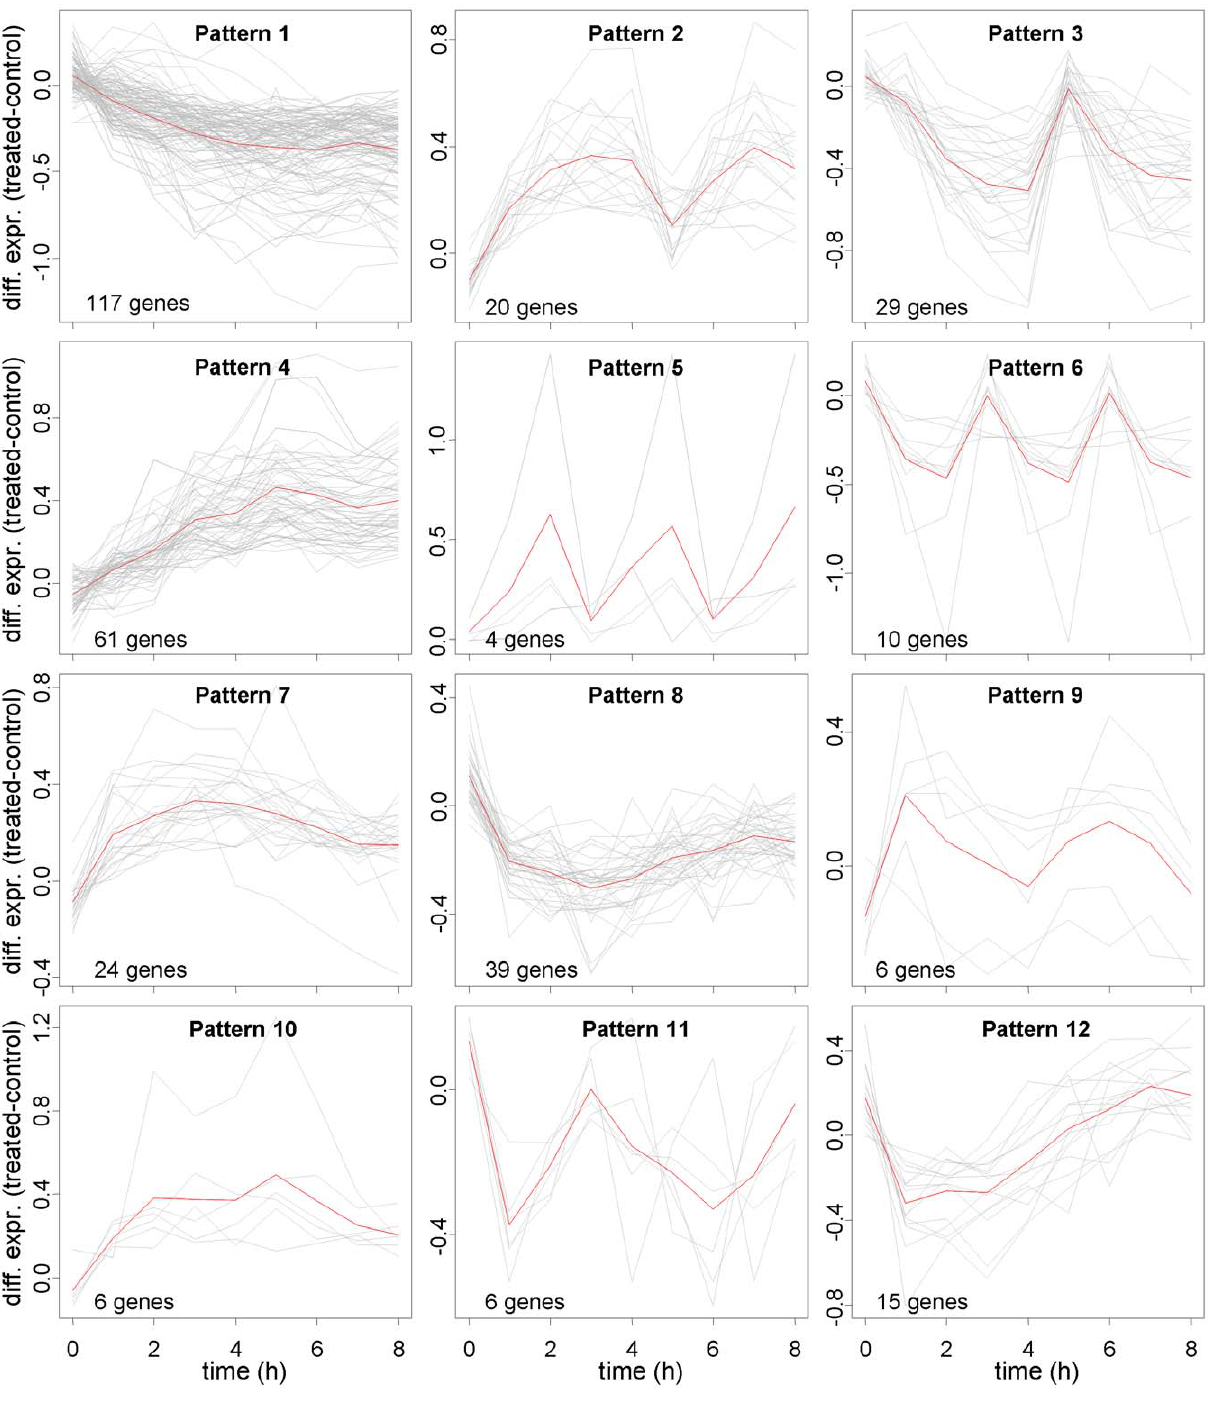
Figure 2. Expression profile of genes selected as differentially expressed clustered in groups of genes sharing the same temporal patterns. The average differential expression profiles (treated minus control) of the genes in the different clusters is shown in red; the number of genes in each cluster and their differential expression profile (in gray) is also reported for each cluster.